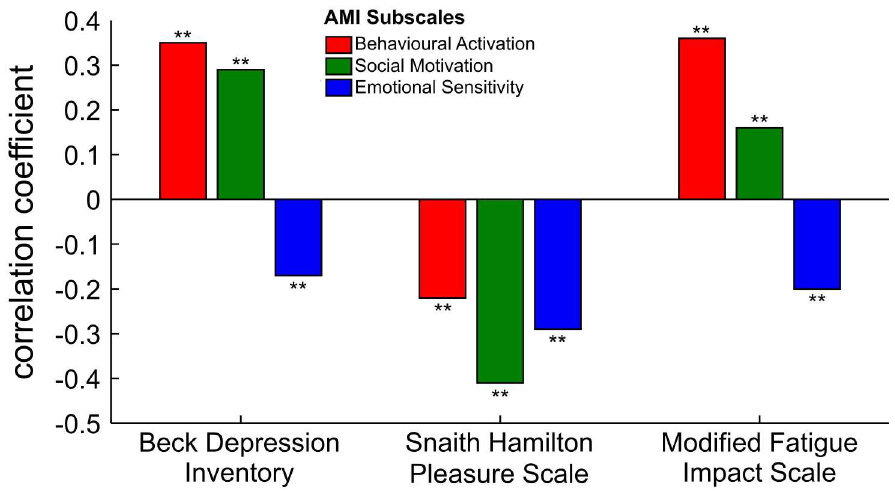
Fig 2. Correlation coefficients between AMI subscales and established measuresof depression, anhedonia and fatigue. BA and SM correlatedpositivelywith BDI and MFIS, indicatingthat individualsthat were more apatheticon these subscales also had higherlevels of depression and fatigue. In contrast the ES scale was negatively correlatedwith depression and fatigue. All three AMI subscales were negatively correlatedwith the SHAPS (lower scores indicate higherlevels of anhedonia), suggestingthat higherapathy was associated with lower hedonia.